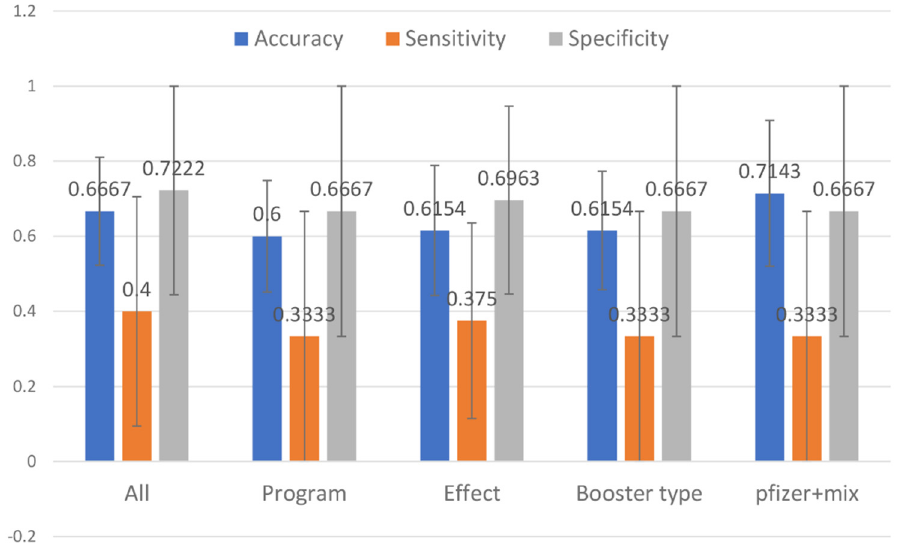
Figure 11. Multinomial regression model performance using all and representative attributes.